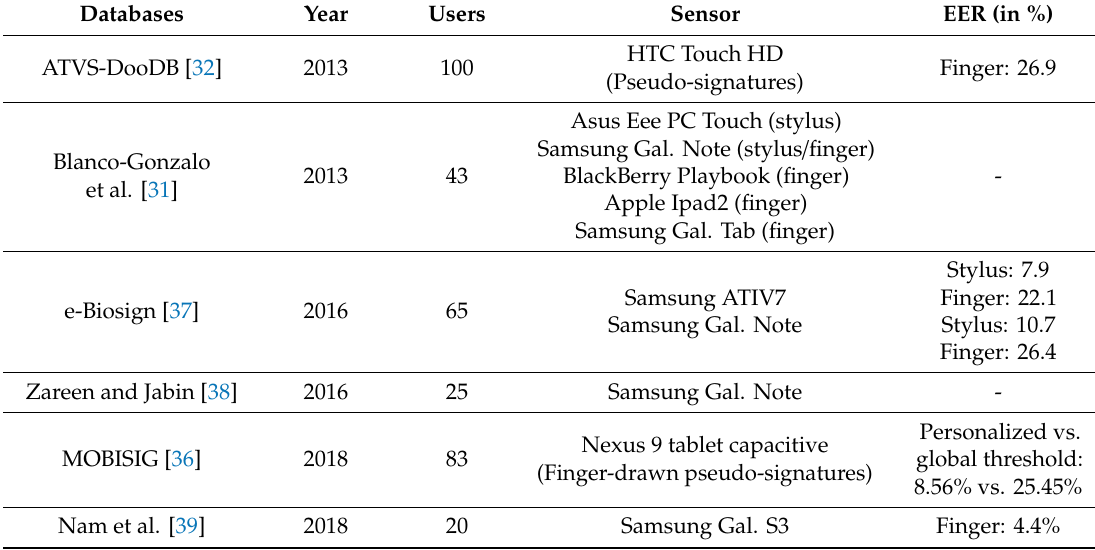
Table 2. Performance of ASV systems of the literature on several online signature databases acquired in mobile scenarios with touch-screen sensors, considering skilled